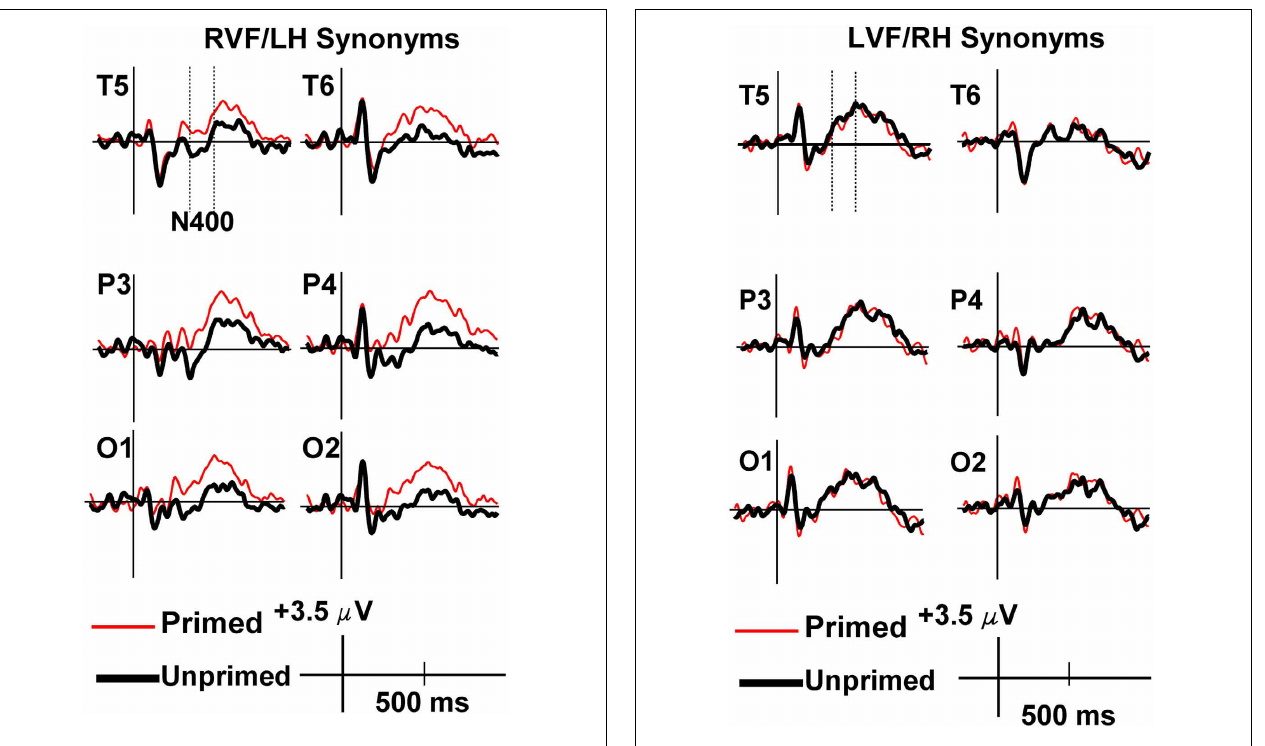
FIGURE 5 | Grand average ERPs recorded to synonym targets presented to the LVF/RH. Synonym targets produced neither significant priming nor inhibition effects in the